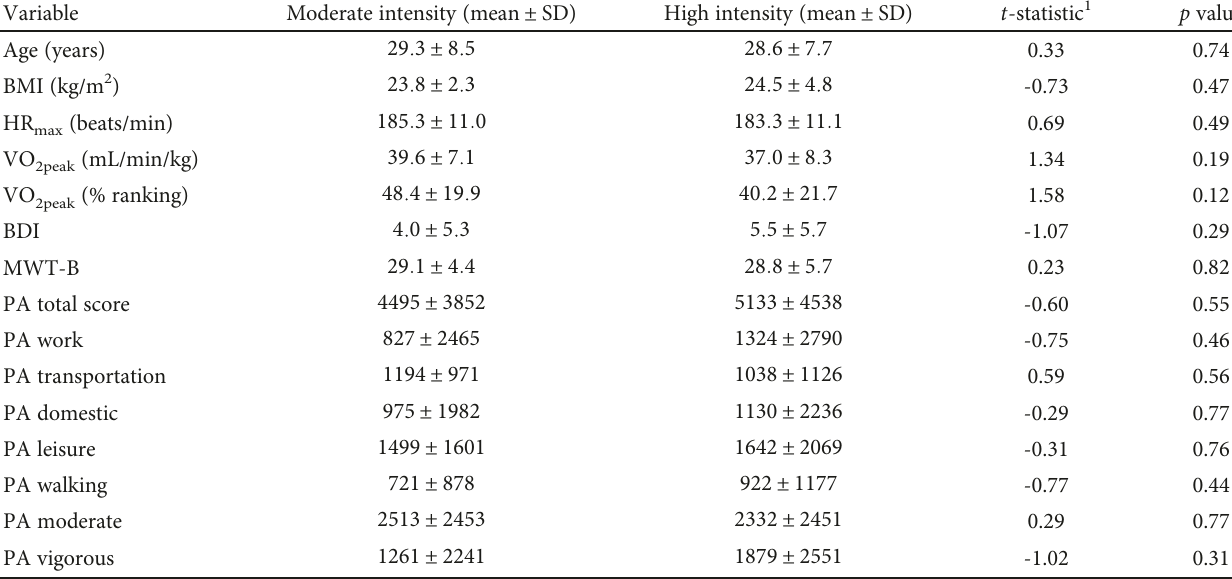
Table 1: Demographic and clinical characteristics of participants in the moderate-intensity and high-intensity groups.